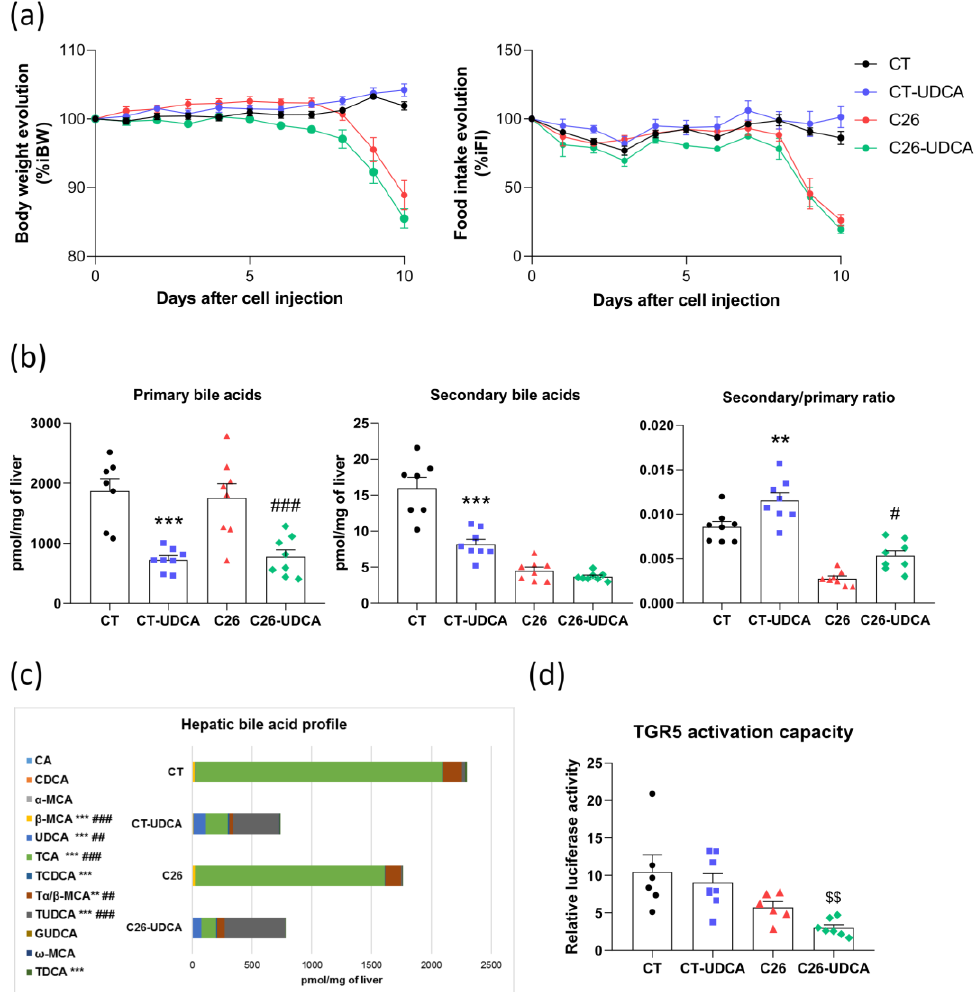
Figure 4. UDCA treatment changes the bile acid profile and decreases TGR5 activation capacity in C26 cachectic mice. ( a ) Body weight and food intake evolution in sham-injected mice (CT), sham-injected mice treated with UDCA (CT-UDCA), mice injected with cachexia-inducing C26 colon carcinoma cells (C26), and mice injected with cachexia-inducing C26 colon carcinoma cells and treated with UDCA (C26-UDCA). ( b ) Primary and secondary bile acid levels and Secondary/primary ratio in the liver of CT, CT-UDCA, C26, and C26-UDCA mice. ( c ) Hepatic bile acid profile in CT, CT-UDCA, and C26 and C26-UDCA mice. ( d ) TGR5 activation capacity using cell reporter assay incubated with portal plasma of CT, CT-UDCA, C26, and C26-UDCA mice. n = 5–8 mice per group; data are presented as mean ± SEM. ** p < 0.01, *** p < 0.001 CT vs. CT-UDCA and # p < 0.005, ## p < 0.01, ### p < 0.001 C26 vs. C26-UDCA. Student t -test C26 vs. C26-UDCA, $$ p <